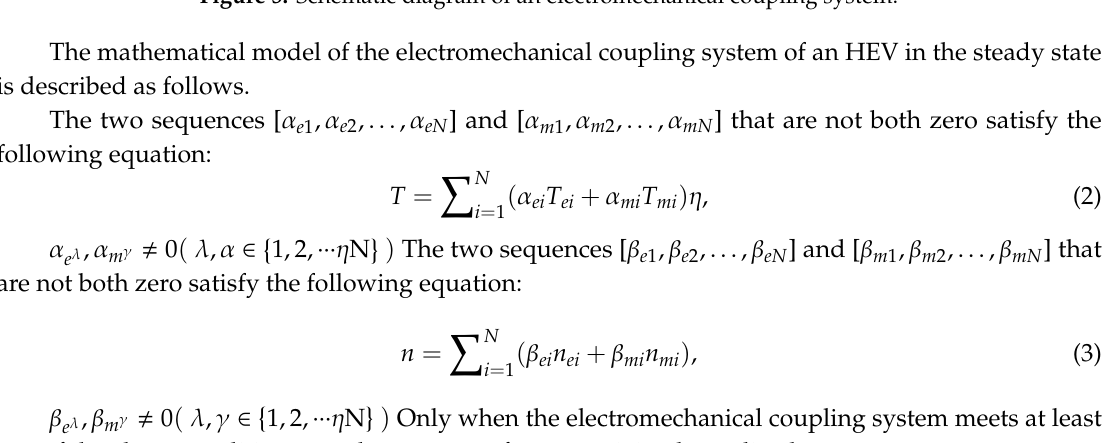
Figure 5. Schematic diagram of an electromechanical coupling system.